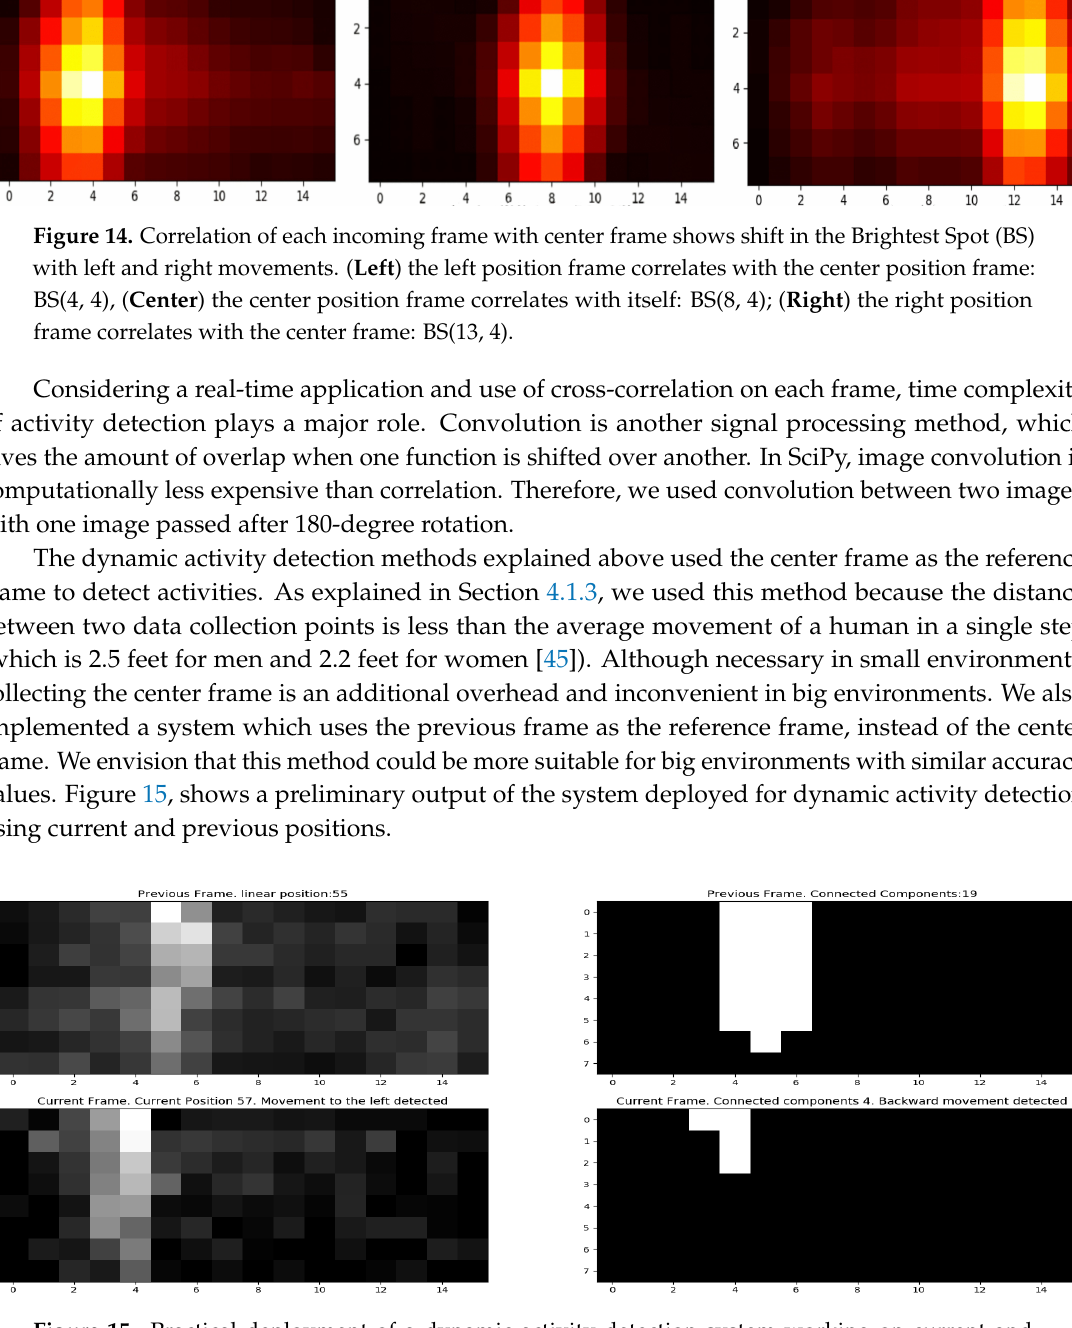
Figure 15. Practical deployment of a dynamic activity detection system working on current and previous frames